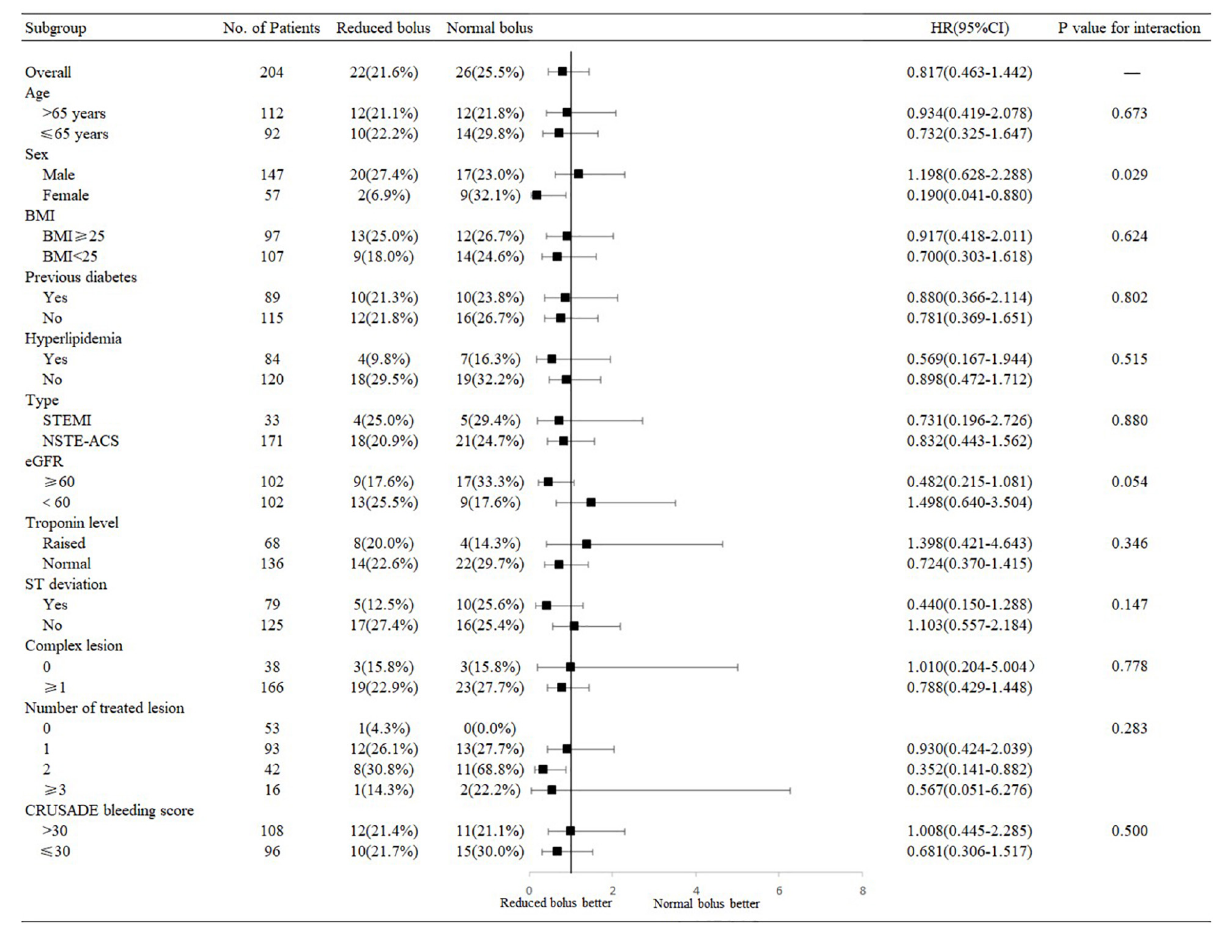
FIGURE 5 | Selected subgroup analyses for the 6-month rates of